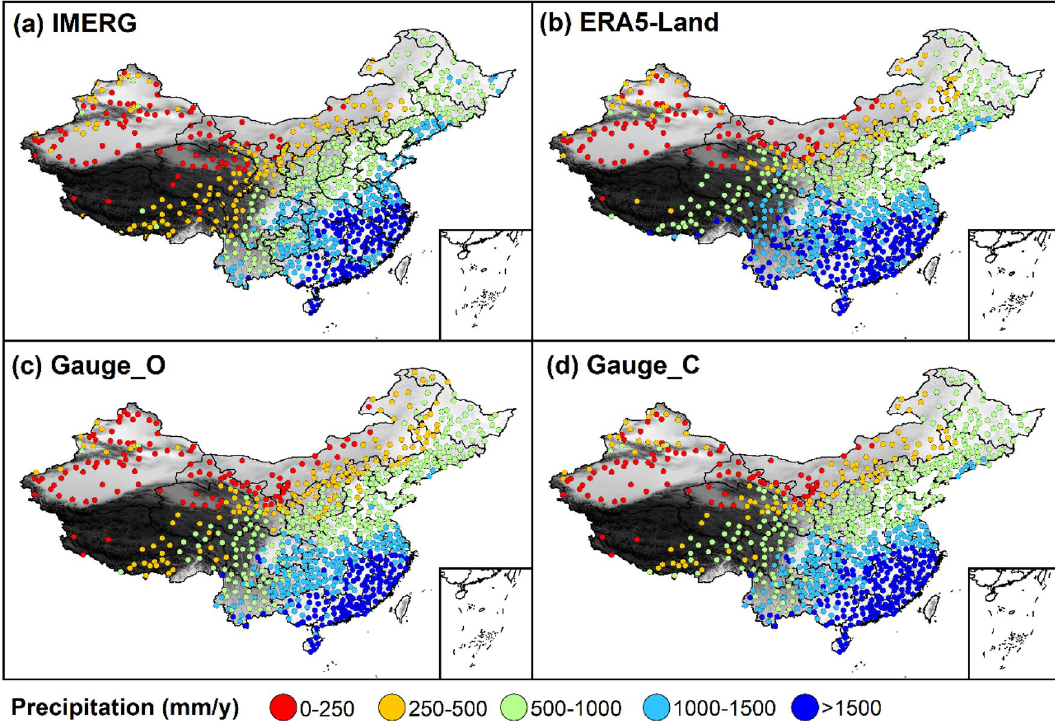
Figure 2. Spatial distribution of annual mean precipitation over China from ( a ) IMERG, ( b ) ERA5-Land, ( c ) Gauge_O, and ( d )